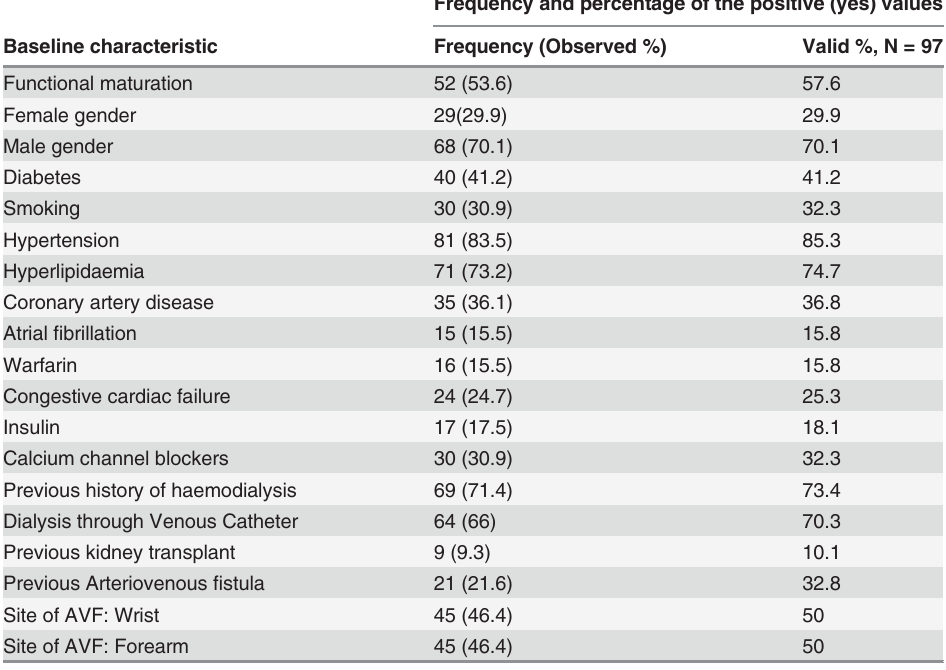
Table 1. Characteristics of patients in study. Frequency and percentage of the positive (yes)